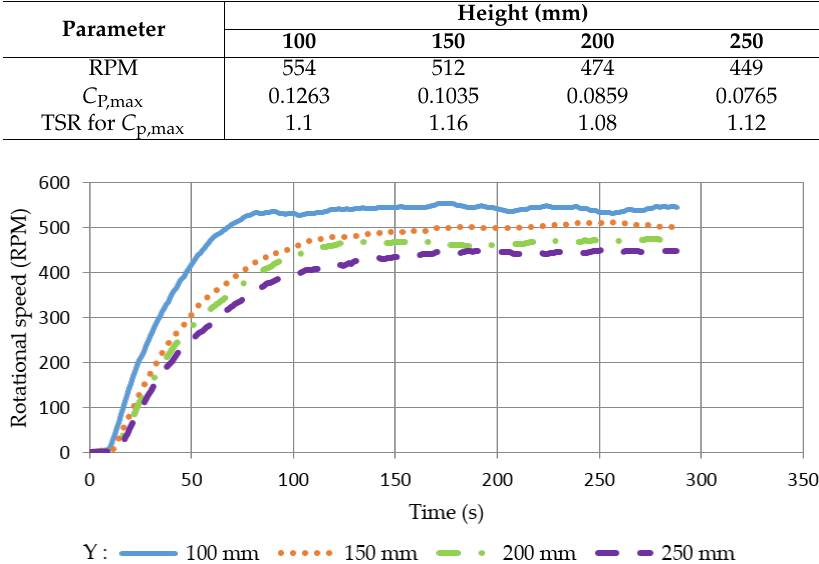
Figure 14. Coefficient of power of CAWT at various heights above the rooftop. Table 4. Summary of experimental results on variation of height. Table 4. Summary of experimental results on variation of height.